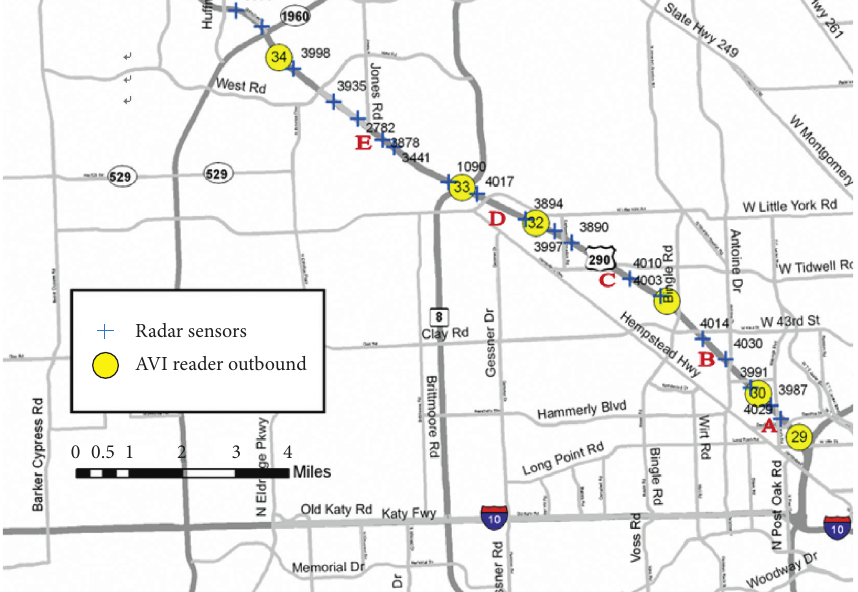
Figure 1: Study links along the US-290 [23].